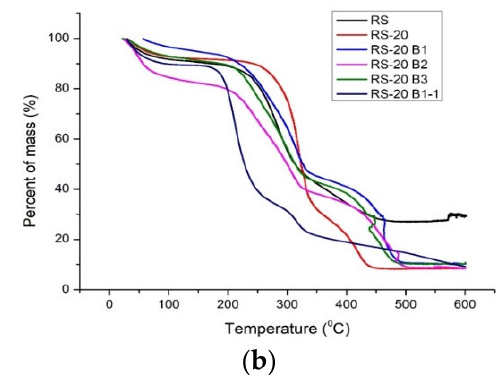
Figure 2. TGA of biomass, pretreated biomass using 20% NaOH, CNC synthesized with different concentration of NaOCl, and modified CNC from ( a ) sugarcane bagasse (SB) and ( b ) rice straw (RS).